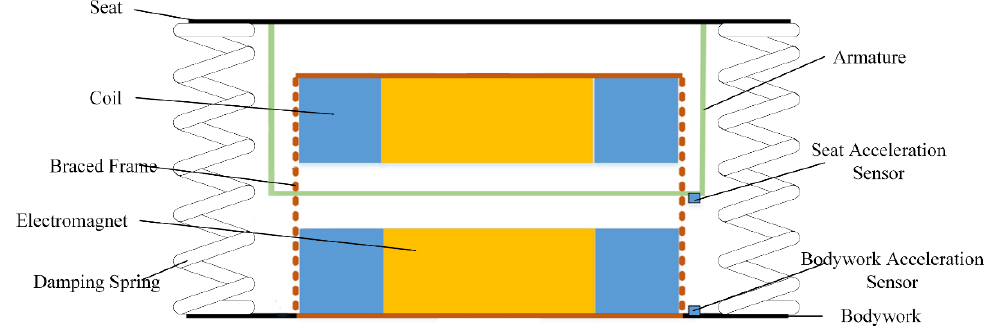
Figure 3. Structure of electromagnetic vibration reduction system.